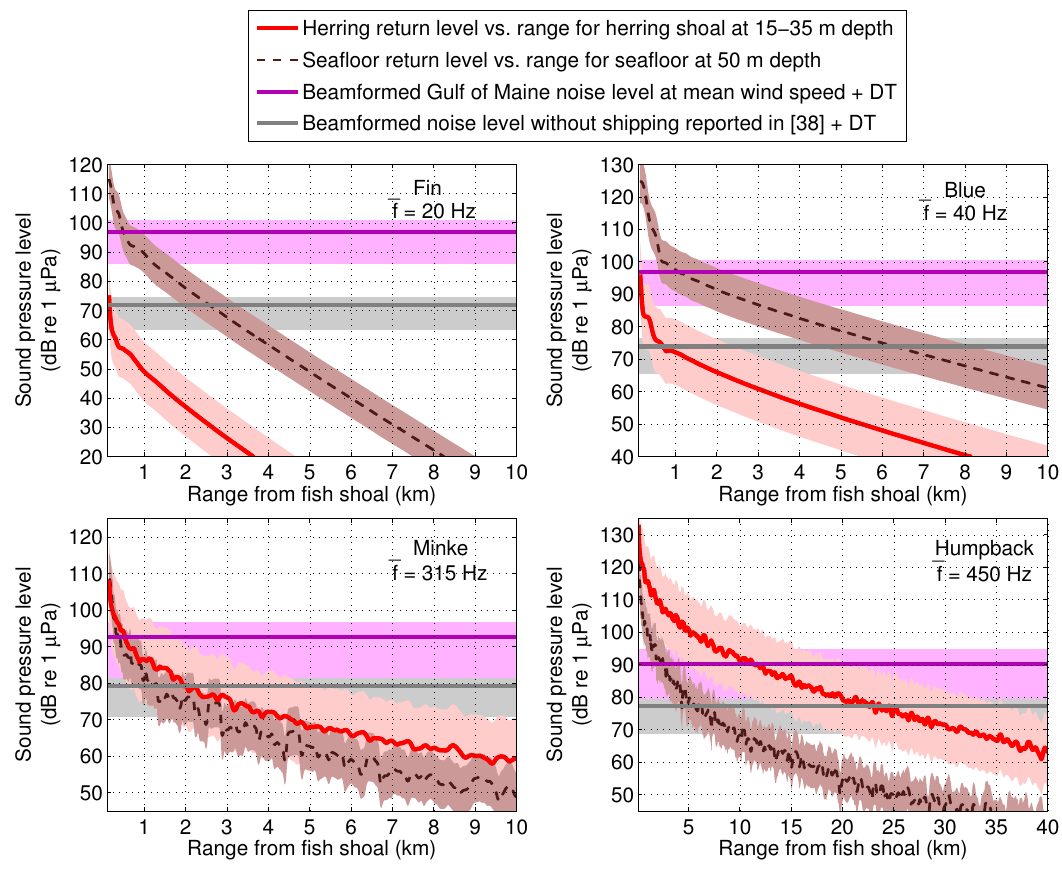
Figure 4. Detections of herring shoals are feasible up to 10 ± 6 km in range for humpback parameters and 1 ± 1 km for minke parameters in common Gulf of Maine herring spawning scenarios of dense near-surface concentrations at depths of 15–35 m (red solid lines). Detections of the seafloor are found to be feasible up to 2 ± 1 km in range for blue and humpback parameters and roughly 1 km for fin and minke parameters over local ambient noise. Dark red dashed lines represent seafloor scattering for a seafloor depth of 50 m. Purple solid lines represent the beamformed ambient noise levels with mean wind speed of 5.6 m/s during peak herring spawning period in the Gulf of Maine with one detection threshold ( DT ) added. Light purple shaded areas range from the beamformed ambient noise levels at 2 m/s wind speed minus 5.6 dB to those at 10 m/s wind speed plus 5.6 dB, to illustrate the typical range of wind-speed-dependent ambient noise encountered. Gray solid lines represent the beamformed ambient noise level without significant shipping with wind speed of 5.1 m/s [38] with one DT added. Light gray shaded areas range from beamformed ambient noise levels without significant shipping at 5.1 m/s wind speed plus/minus the instantaneous intensity standard deviation of 5.6 dB. The beamformed ambient noise levels are determined for frequency bands of baleen whale vocalizations given in Table 1 using Equations (9) and